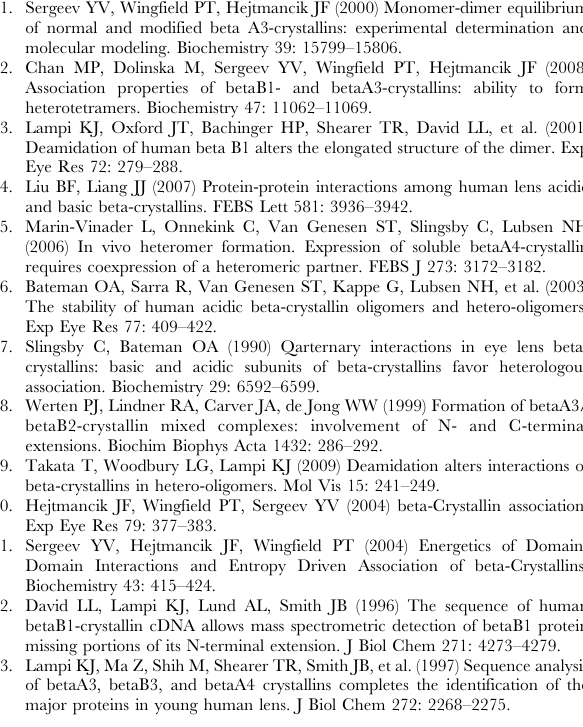
Table S1 Dissociation constants ( K d ) and changes in Gibbs free energy of association obtained at different temperatures for the formations of dimeric b B1, and b A3, and tetrameric b B1/ b A3 Association free